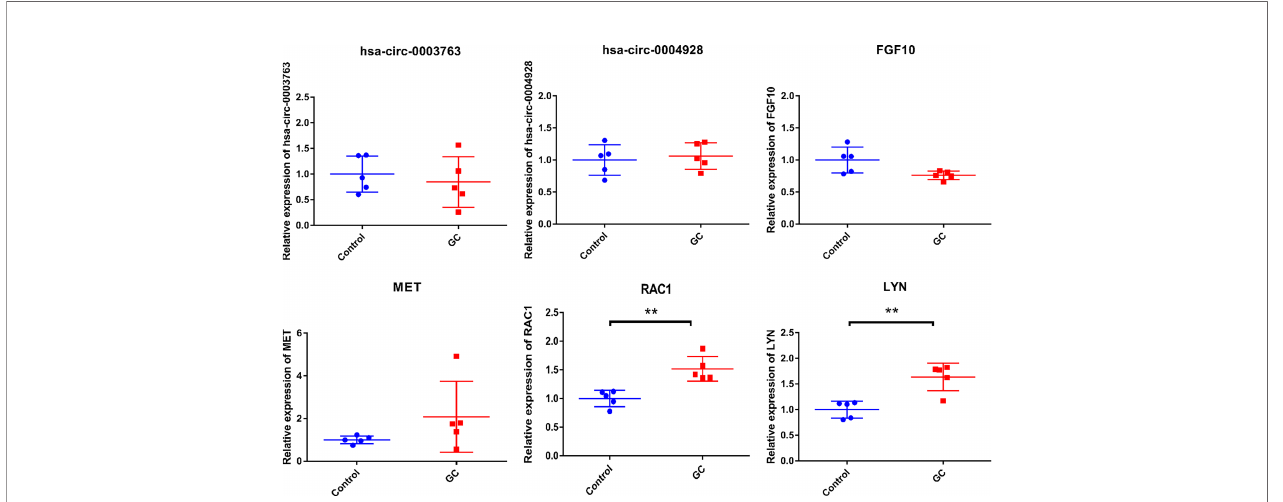
TABLE 6 | Clinical information of individuals in the in-vitro experiment. Group Age Gender Height Weight Pathological (years) (cm) (kg) grading